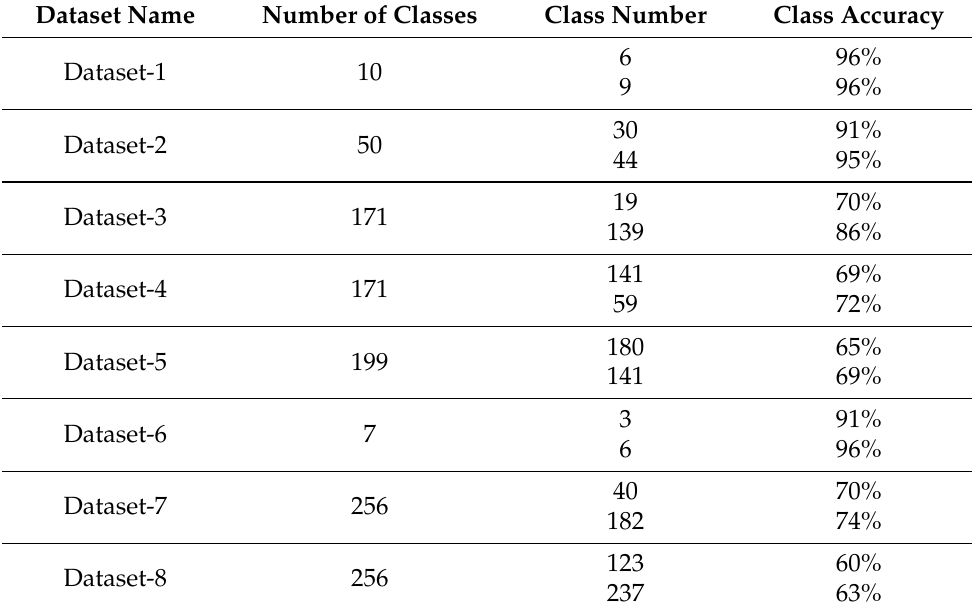
Table 11. Two Worst-Performing Classes for 8 Datasets.